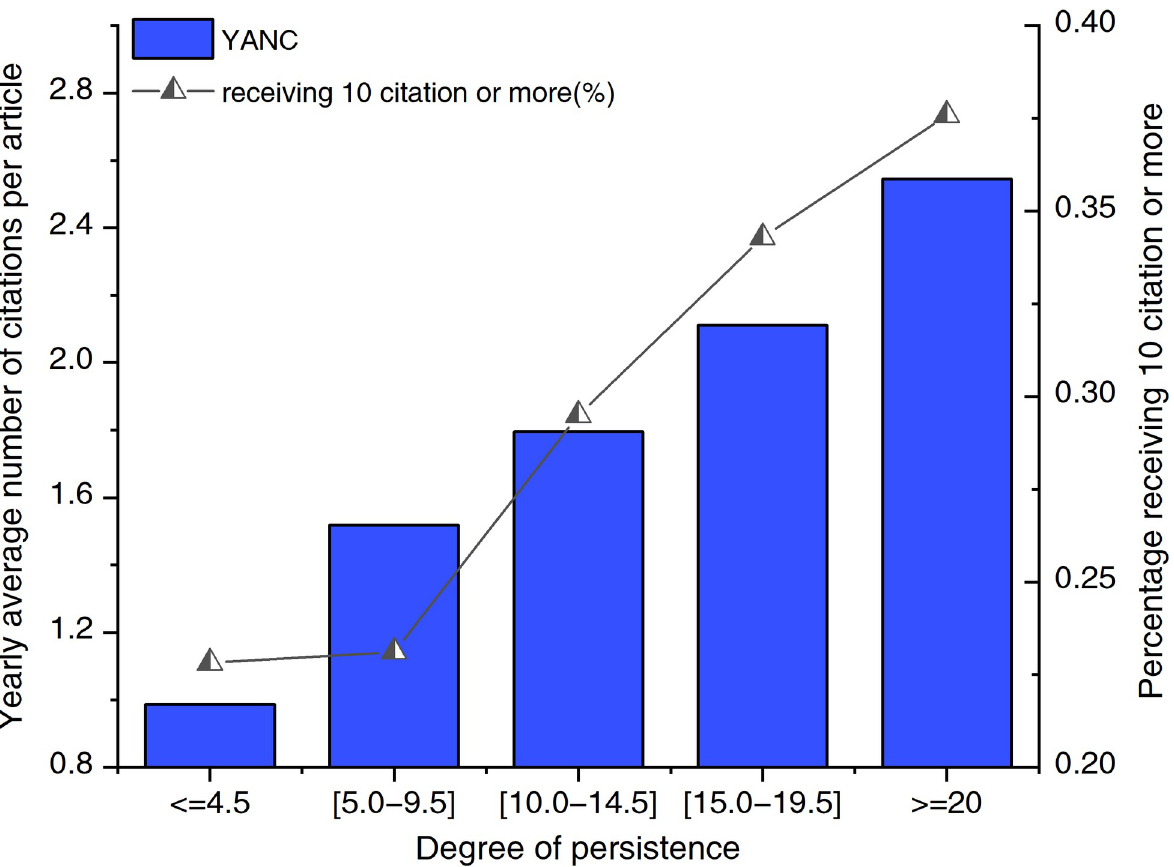
Fig 6. Yearly average number of citations (YANC) received per article and the proportion of coauthored articles that have received at least 10 citations (CAP10C) per year for different persistence groups in 1993–2013.